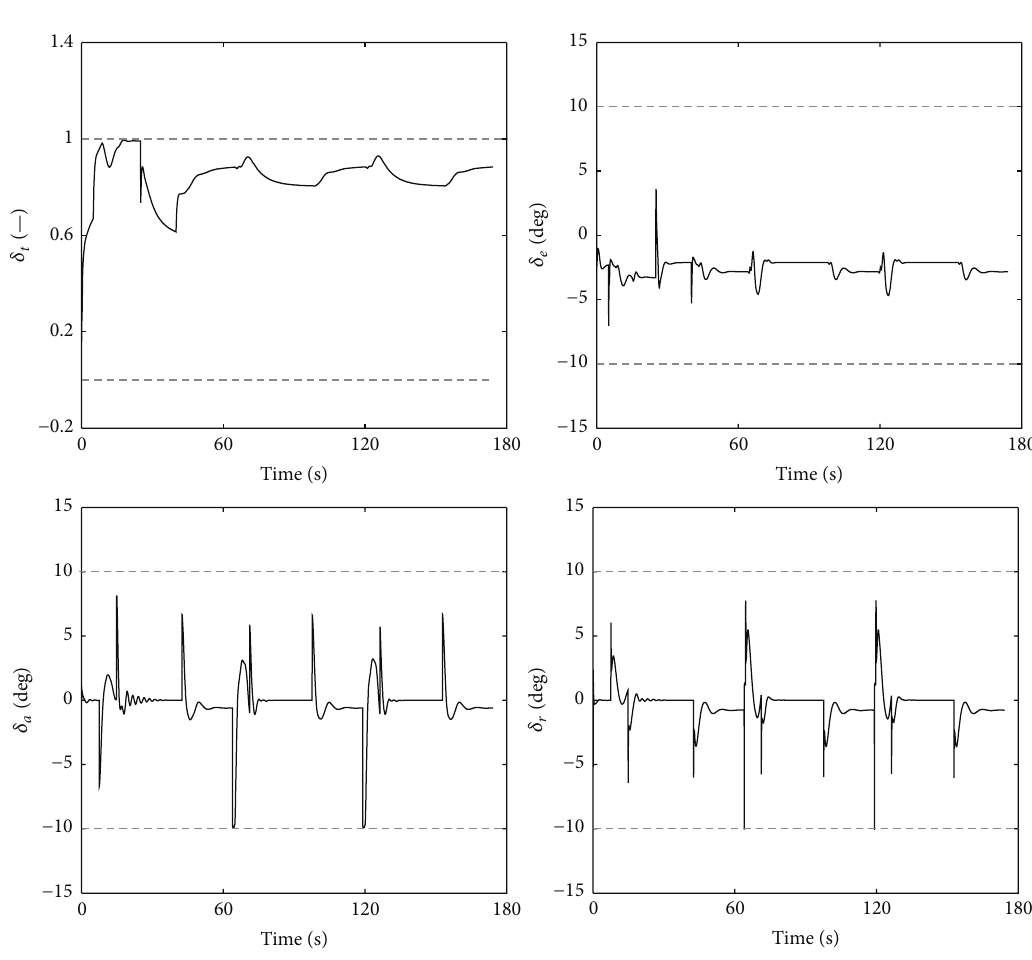
Figure 8: Inputs in the simulation with reduced power and stability.